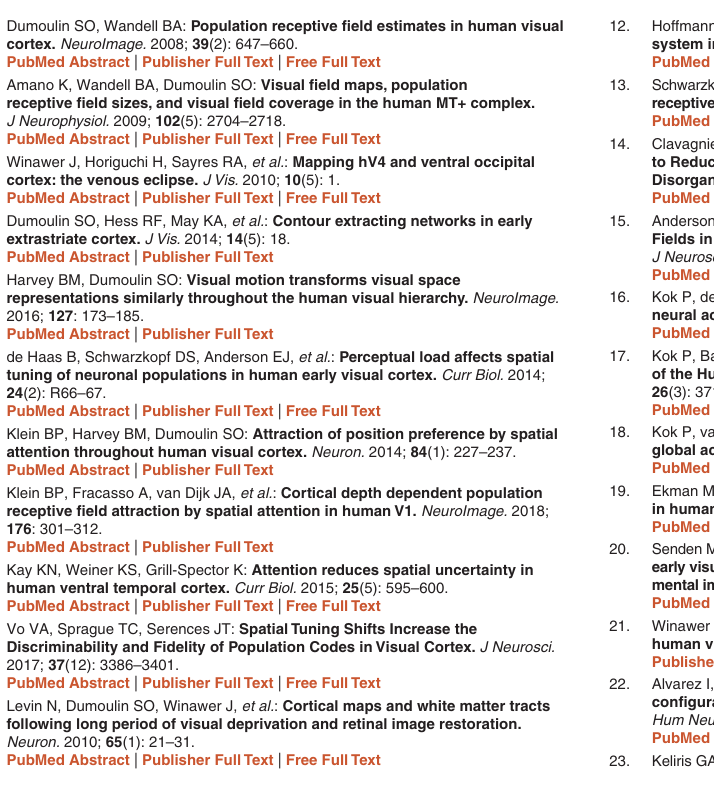
Supplementary Figure 3. https://osf.io/chtra Mean population receptive field (pRF) size (A) and median goodness-of-fit (B) binned into eccentricity bands for the Auckland data without filtering (black), and low-pass filtering with kernel 1 s (blue) and 2 s (green). Panels in columns show different visual regions. Panels in rows show the three par- ticipants. Error bars denote 95% confidence intervals based on